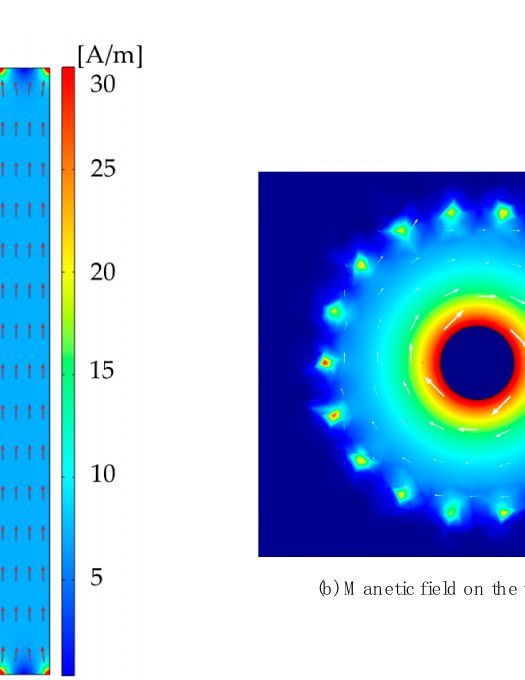
Figure 10. The surface current (2-D model) and magnetic field on the tangential plane of the aluminum barrel (3-D model).